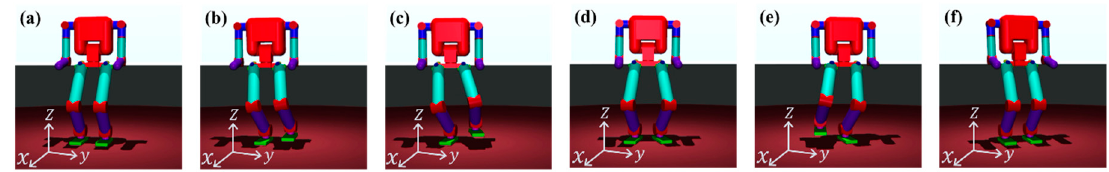
Figure 4. Turning. ( a ) Initial position, ( b ) moving zero-moment point above the right foot, ( c ) left-foot lifting and both left leg and body turning, ( d ) left foot lowering, ( e ) right foot lifting and both right leg and body turning, and ( f ) motion completion.